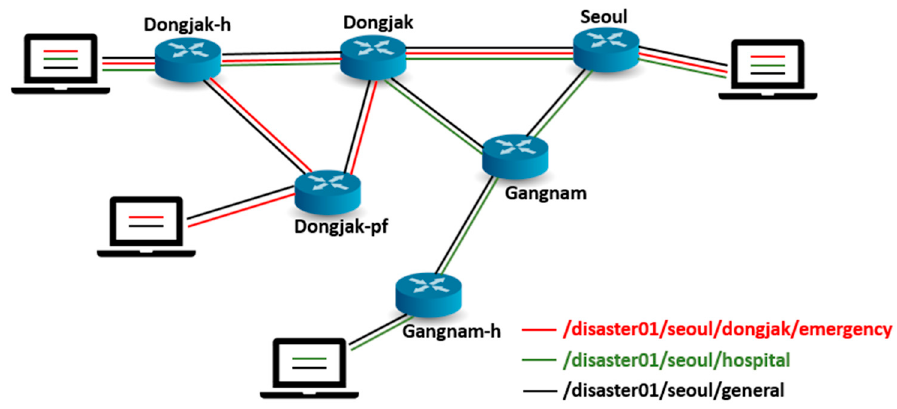
Figure 6. Multiple concurrent NDN group messaging channels in Seoul disaster scenario.